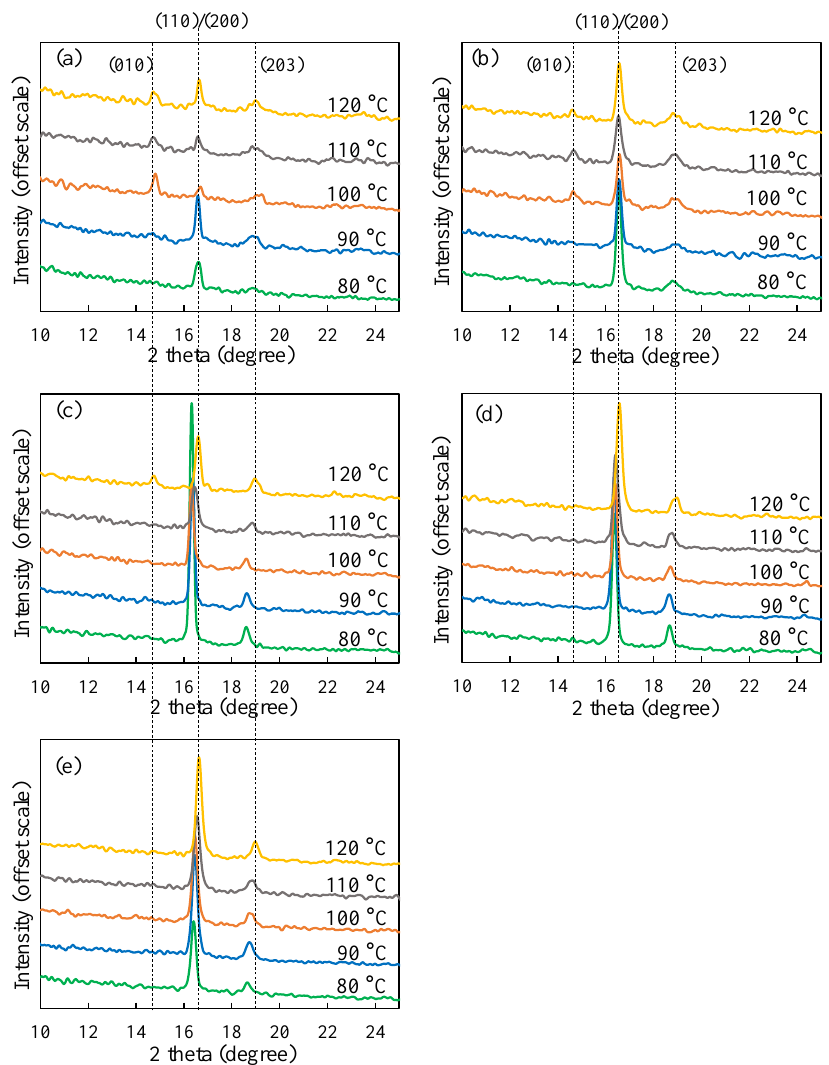
Figure 4. WAXD curves of five PLLA samples obtained by crystallization at different